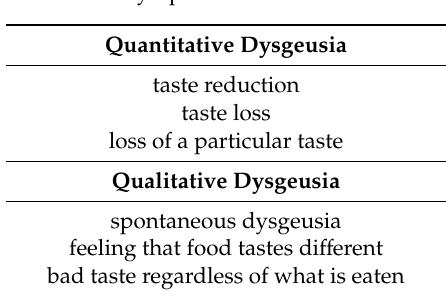
Table 3. Symptoms of taste